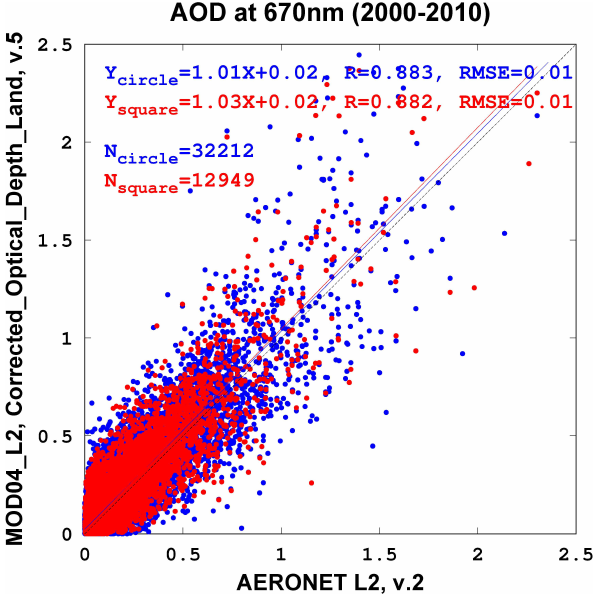
Fig. 2. Impact of the sampling approach on the correlation coeffi- cient ( R ) between means of AERONET AOD and Terra MODIS Collection 005 AOD (QA=3) at 670nm over land. Circle-based sampling used in the new MAPSS shows results similar to the square-based sampling used in the original